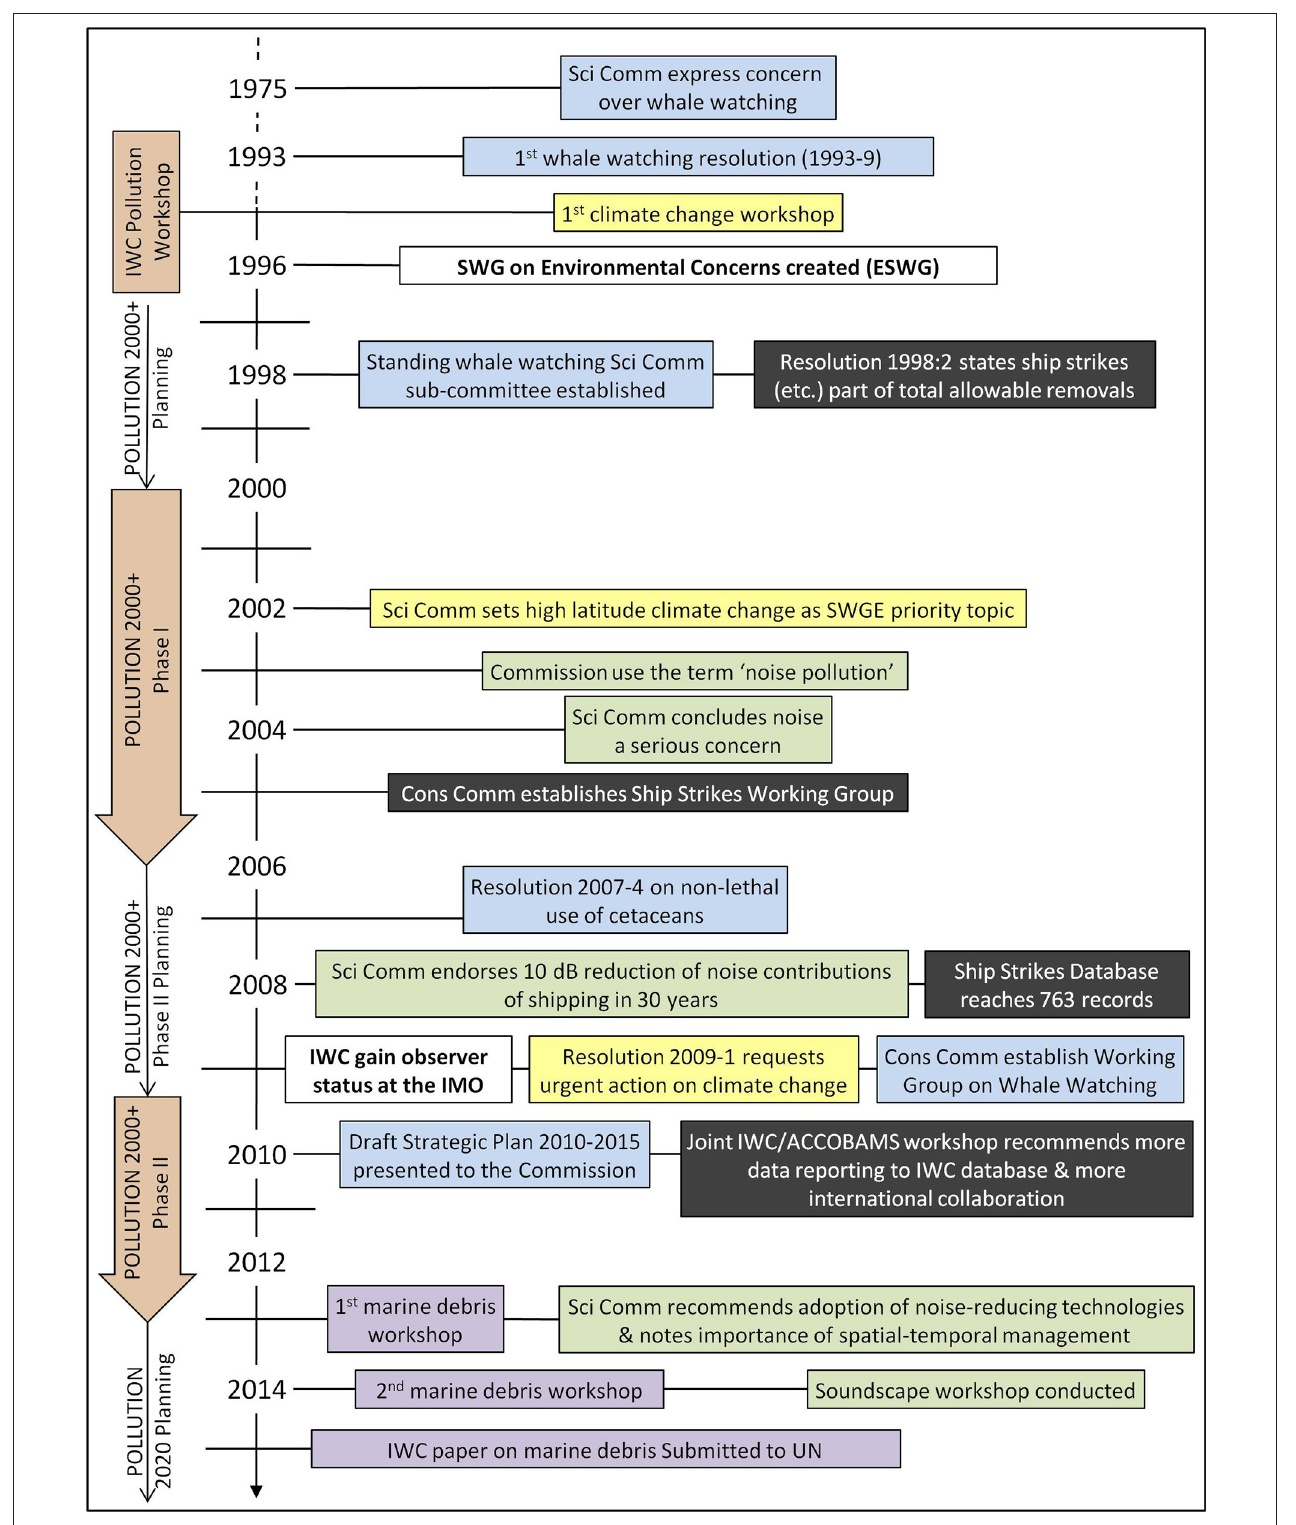
FIGURE 1 | Notable events in the expansion of subjects under consideration at the IWC.